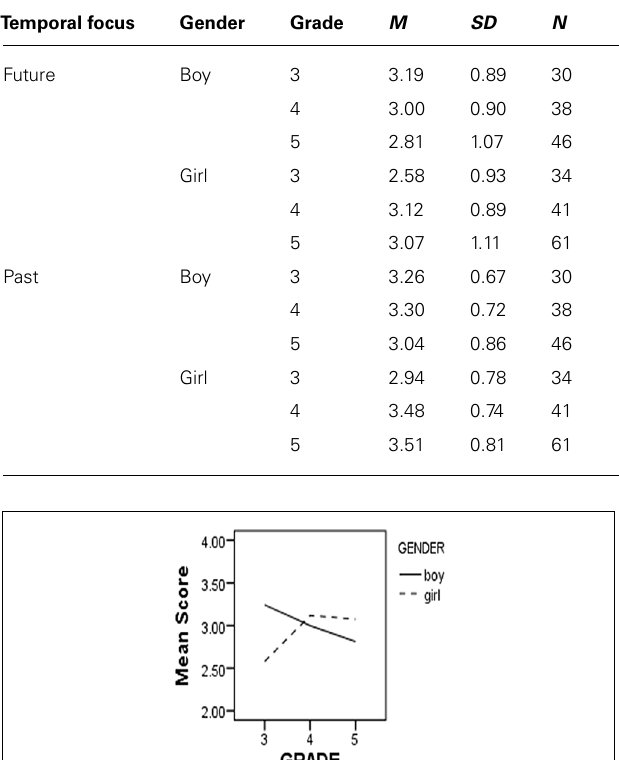
Table 3 | Descriptive statistics of different temporal focus between gender and grade in theTFMWQ-C ( N = 250). Temporal focus